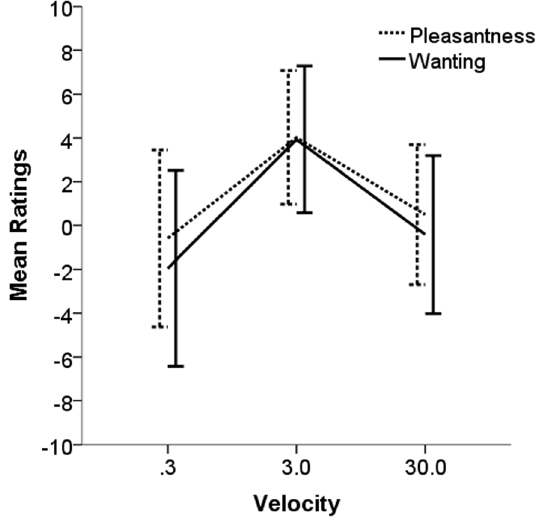
Figure 2. Mean pleasantness and wanting ratings for the three different stroking velocities in Experiment 1 (within subjects). Stroking at 3 cm/s was rated as significantly more pleasant and wanted than stroking at 0.3 or 30 cm/s. However, there was no significant difference between the value of pleasantness or wanting of touch at 3 cm/s stroking, whereas pleasantness was significantly higher for stroking at 0.3 and 30 cm/s.